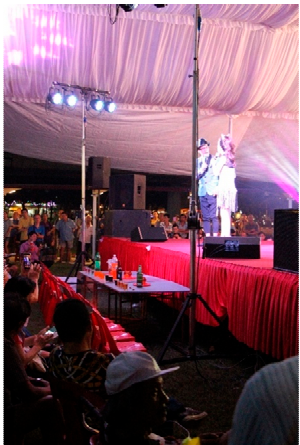
Figure 1. Front Row seats for the spirits at a Getai performance at the open field at Eunos, 2017 (Image: Alvin Eng Hui Lim).